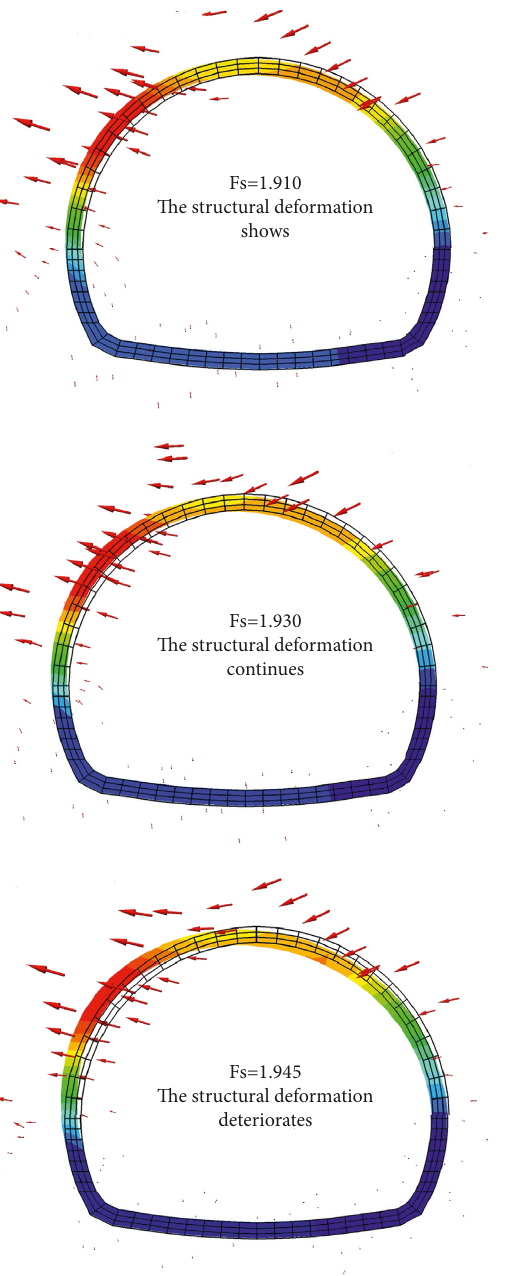
Figure 15: Displacement cloud diagram and deformation shape of the tunnel lining